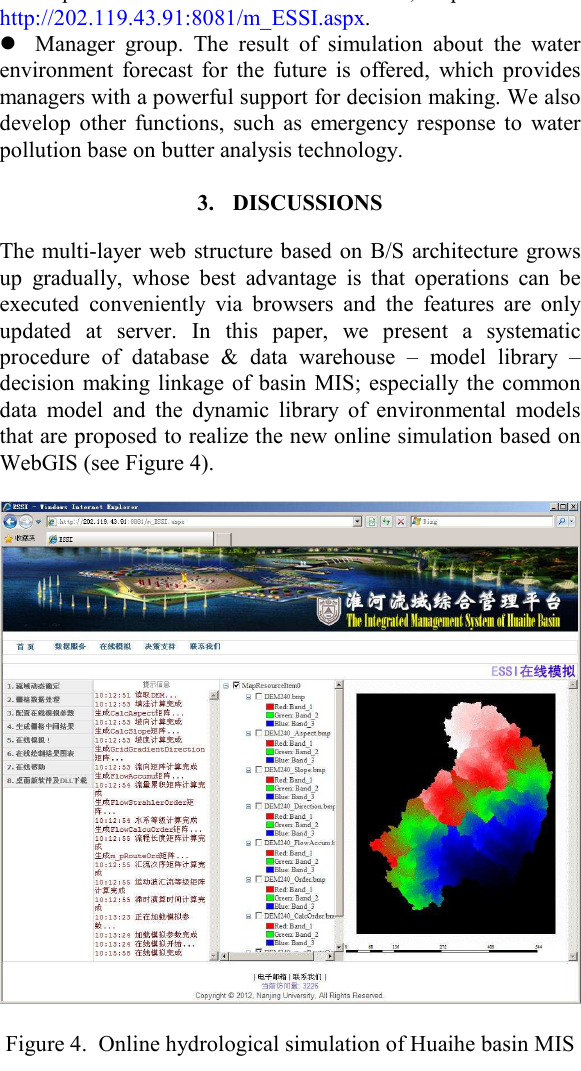
Table 2. Permissions and functions of different groups